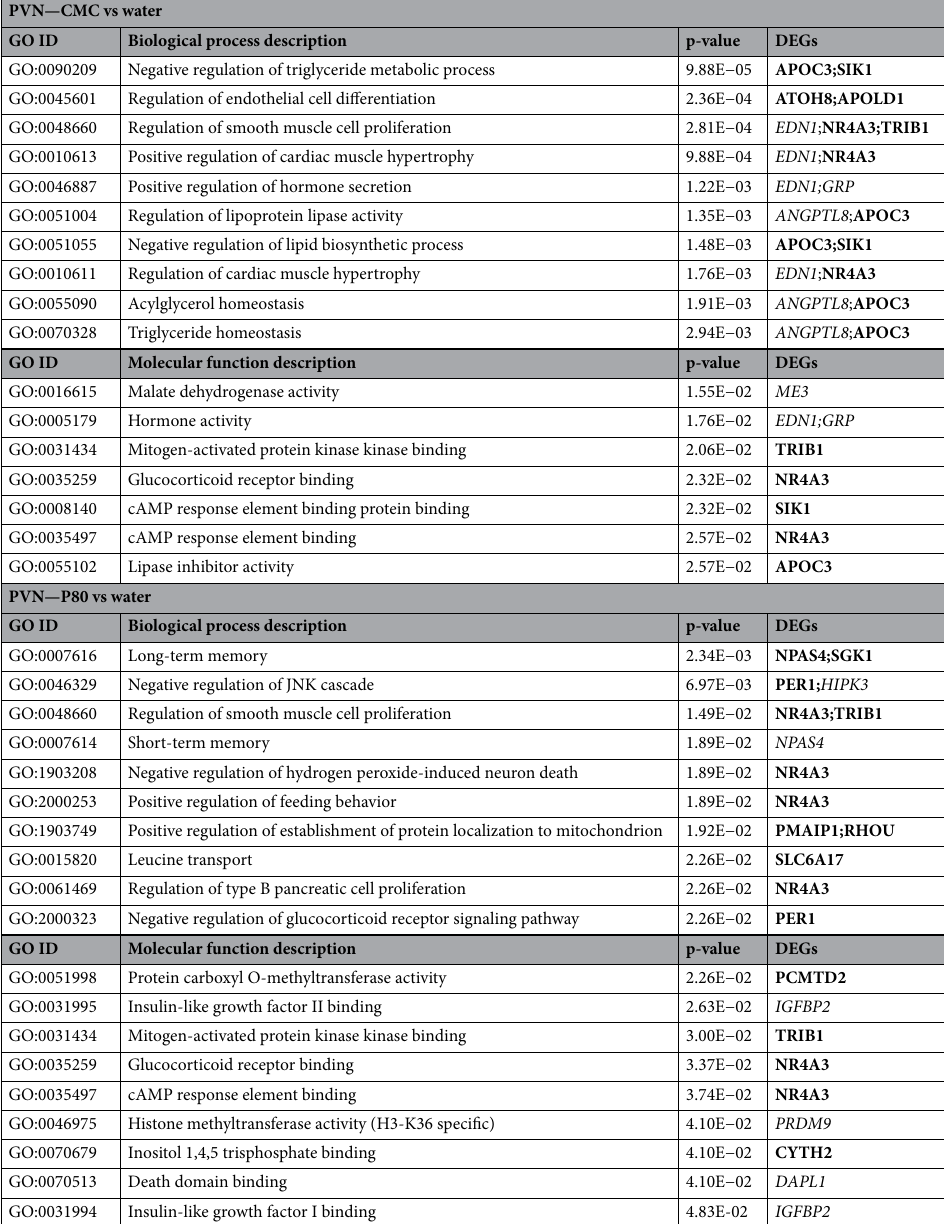
Table 2. Gene ontology of differentially expressed genes in the PVN of emulsifier treated mice. Using EnrichR, differentially regulated gene lists were evaluated for significant enrichment against the following gene set libraries: GO Biological Process, GO Molecular Function (all from http:// www. geneo ntolo gy. org). The top 10 enriched terms were selected and ranked based upon the combined score that was calculated by the EnrichR platform following Z-score permutation background correction on the Fisher exact test p-value. Results were filtered for p < 0.05. Upregulated genes in bold and downregulated genes in